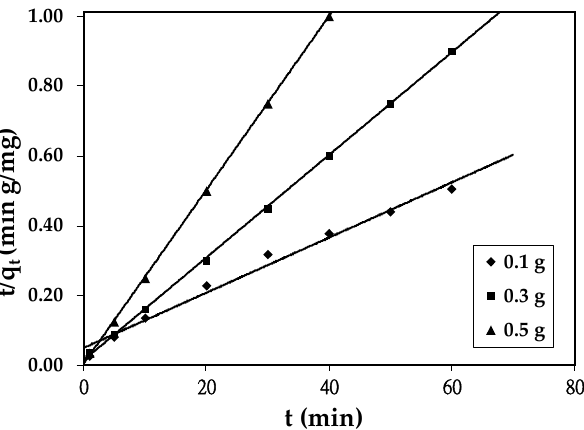
Figure 5. Variations of dimensionless concentration (C t /C 0 ) vs. time under various WCH-AC dosages (initial MB concentration = 10 mg/L, initial pH = 7.0); symbols: experimental data, full lines: obtained from the pseudo-second-order model parameters (Table 2). Table 3. Pseudo-second-order model parameters for MB adsorption onto WCH-AC at various initial MB concentrations. a